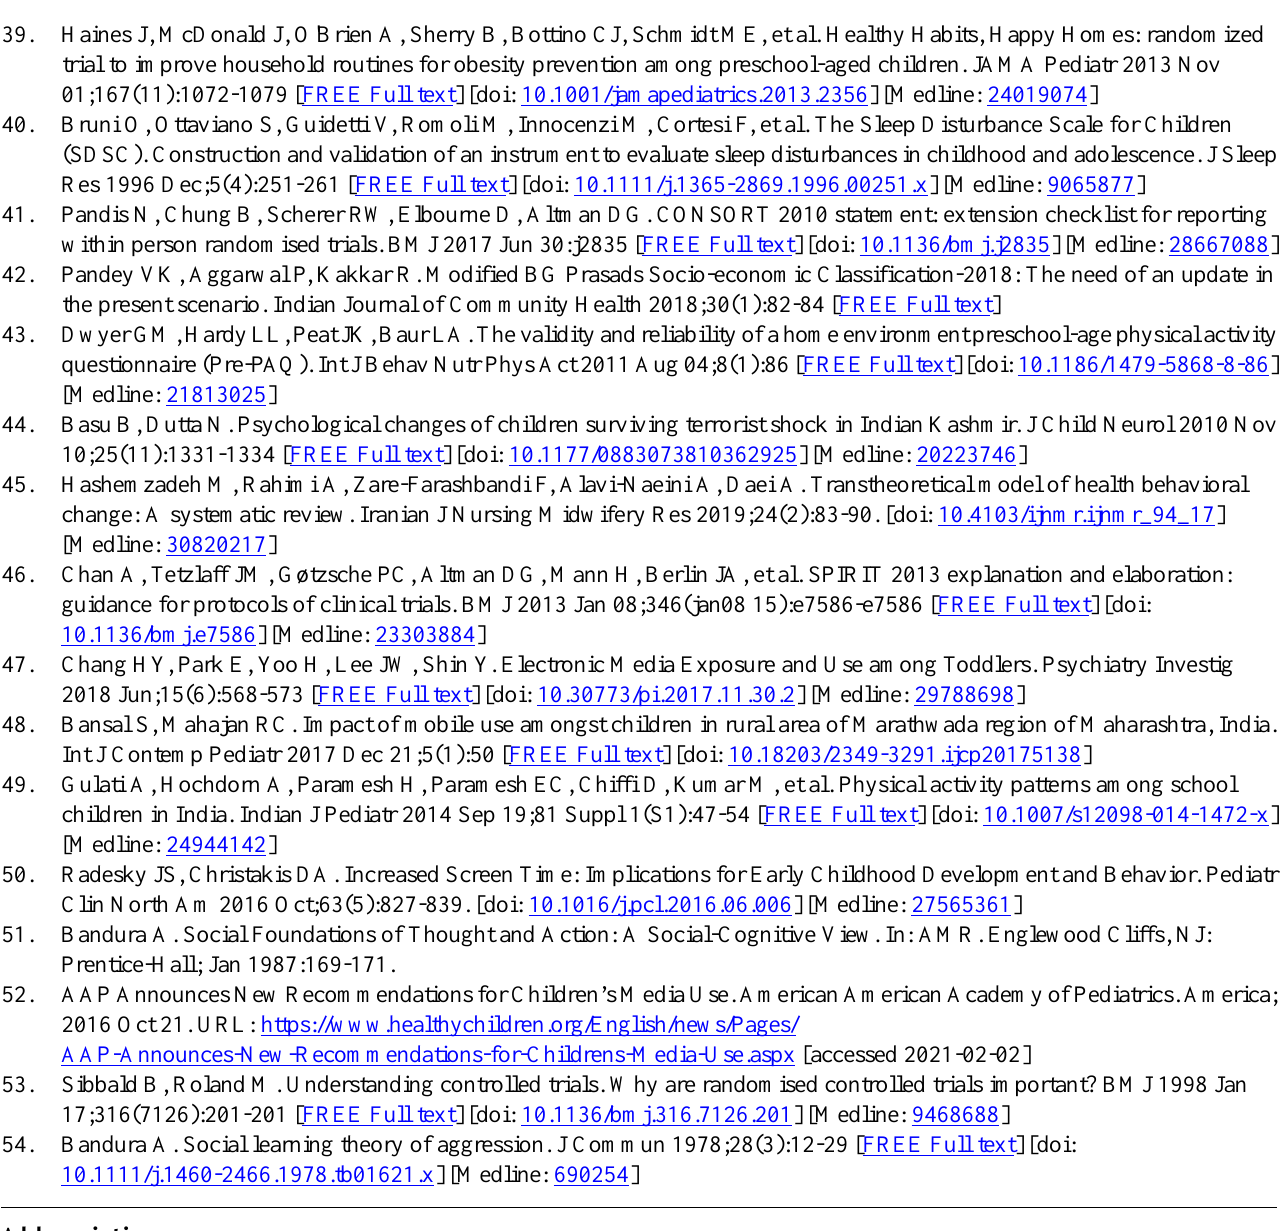
CONSORT: Consolidated standards of reporting trials statement DSEQ: Digital Screen Exposure Questionnaire NCD: noncommunicable disease PLUMS: Program to Lower Unwanted Media Screens SPIRIT: Standard Protocol Items: Recommendations for Interventional Trials ST: screen